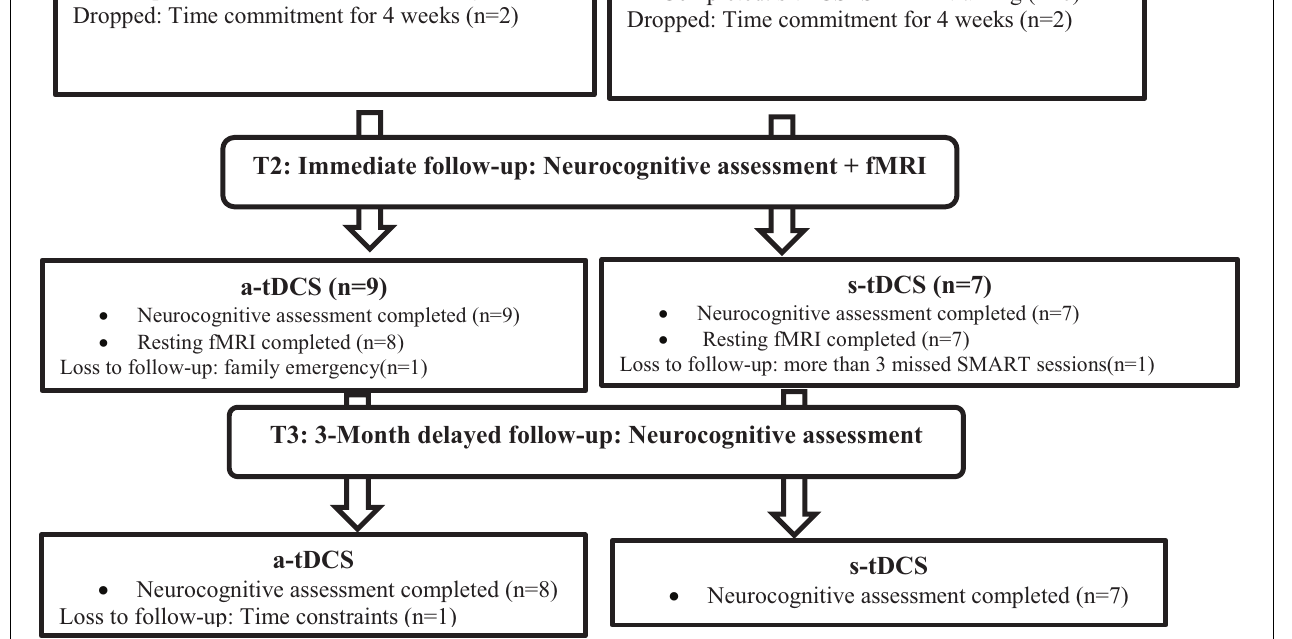
FIGURE 1 | The flow chart of participants follow-up through the research.